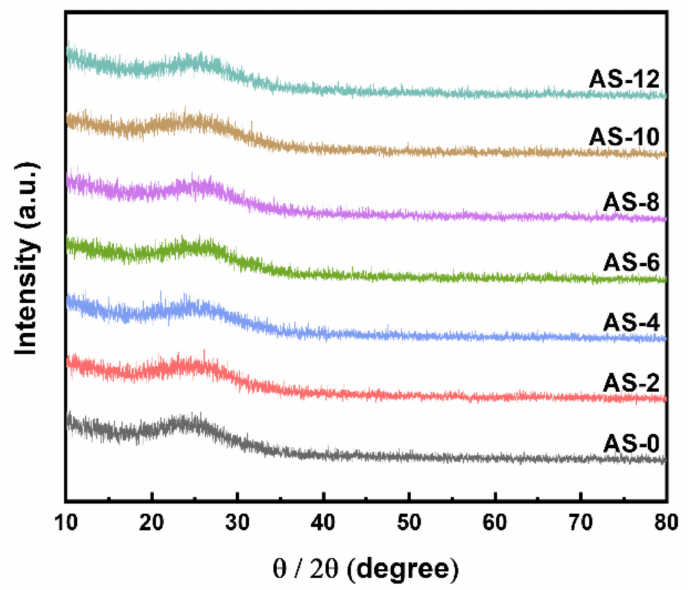
Figure 2. X-ray diffraction patterns of the synthesized aluminum silicate powder with different ammonia